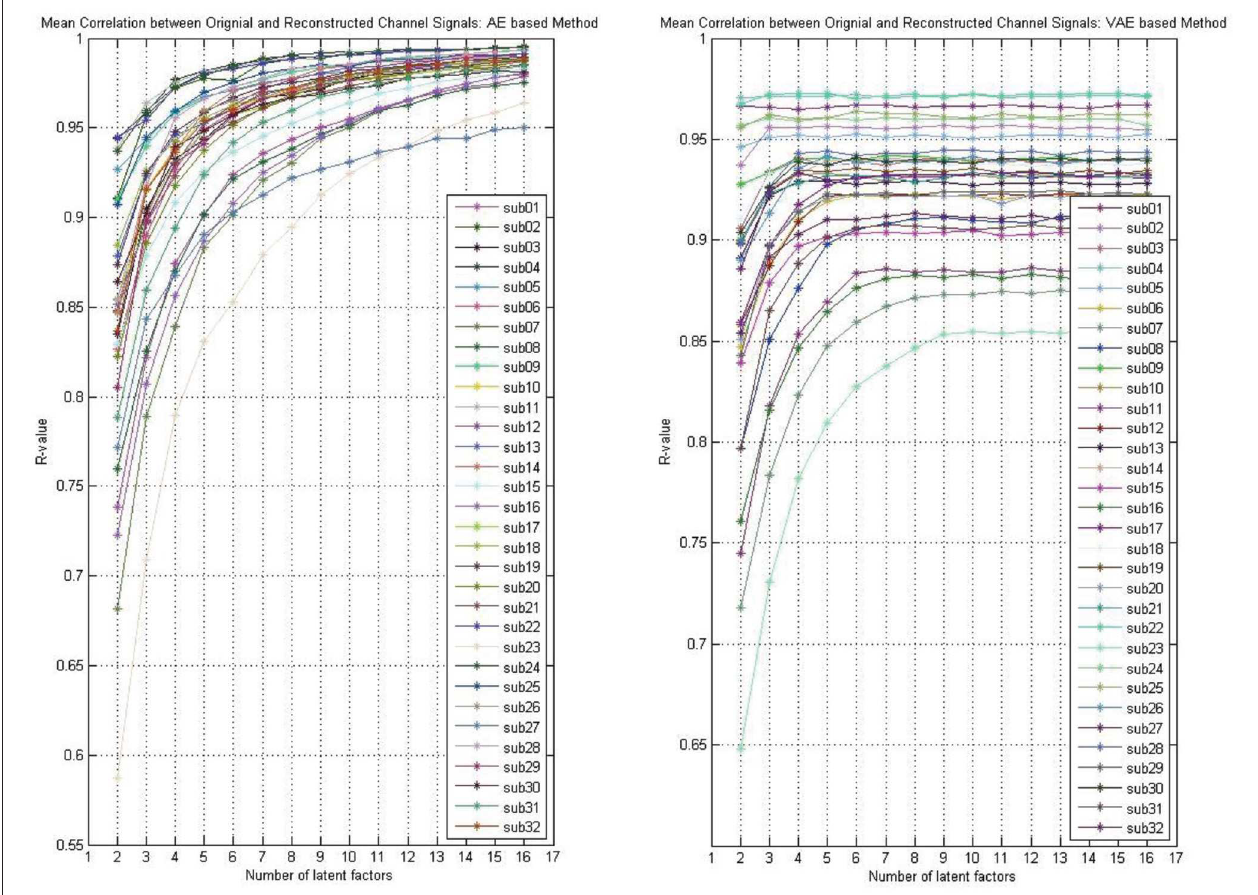
FIGURE 4 | The reconstruction performance (mean Pearson correlation coefficient) of different subjects when assuming a different number of latent factors (take the DEAP for example).